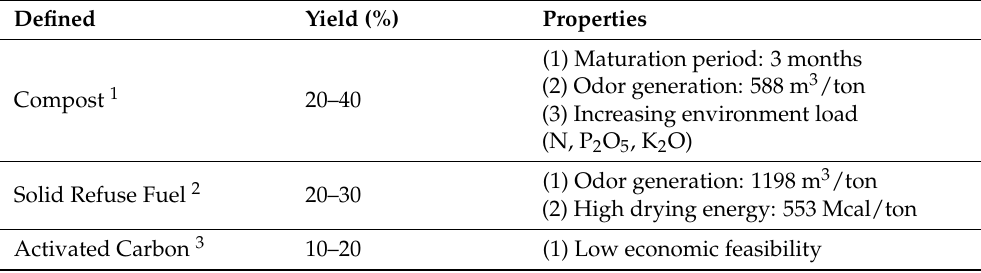
Table 1. Future technological development areas for adding value to livestock byproducts [5]. Defined Yield (%) Properties